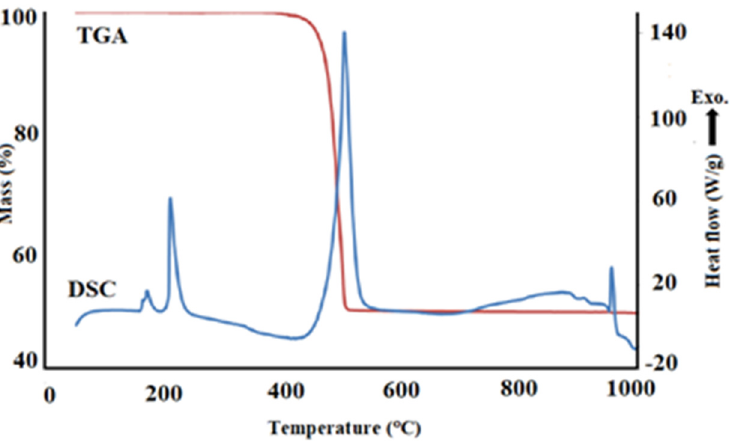
Figure 1. DSC-TGA analysis of AgNO 3